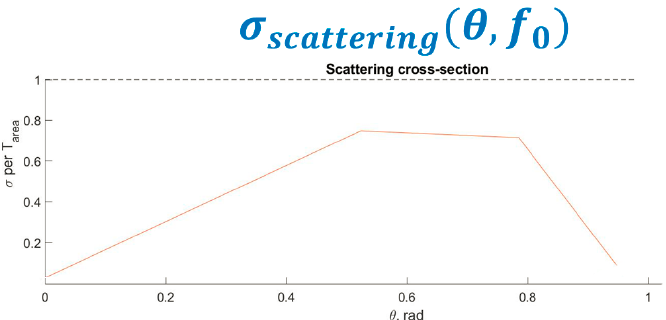
Fig. 4. Scattering cross-section